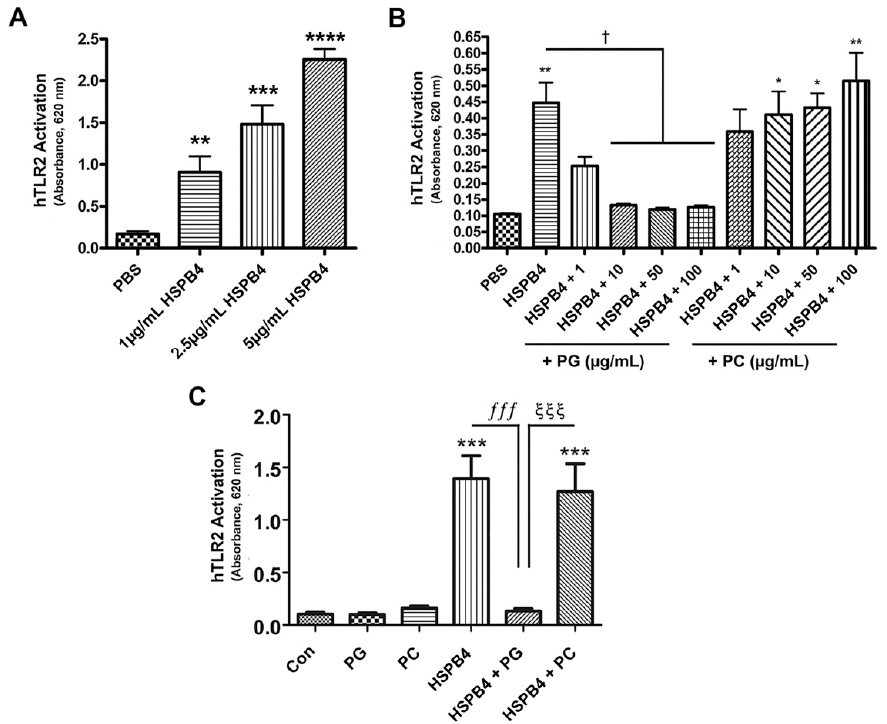
Figure 4. The HSPB4-induced activation of TLR2 was inhibited by DOPG, but not DOPC, at low concentrations. hTLR2 activity was quantified as the change in the absorbance of SEAP detection medium at 620 nm. Experiments were performed on three separate occasions, with results representing the means ± standard error of the mean. ( A ) hTLR2-expressing cells were treated with 1, 2.5, or 5 µg/mL recombinant HSPB4 for 24 h. HSPB4 activated TLR2 in a dose-dependent manner. ** p < 0.01, *** p < 0.001, **** p < 0.0001 versus the control (PBS). ( B ) Cells expressing human TLR2 receptors were treated with 1 µg/mL recombinant HSPB4 in the presence or absence of 1, 10, 50, or 100 µg/mL DOPG or DOPC. DOPG, but not DOPC, inhibited HSPB4-induced TLR2 activation at all tested concentrations. * p < 0.05, ** p < 0.01 versus PBS control; † p < 0.05 versus HSPB4 alone. ( C ) hTLR2 cells were treated with 10 µg/mL DOPG or DOPC in the presence or absence of 1 µg/mL recombinant HSPB4. DOPG, but not DOPC, inhibited hTLR2 activation by HSPB4. *** p < 0.001 versus the control (PBS); ξξξ p < 0.001; fff p < 0.001 as indicated, using ANOVA with Tukey’s post-hoc